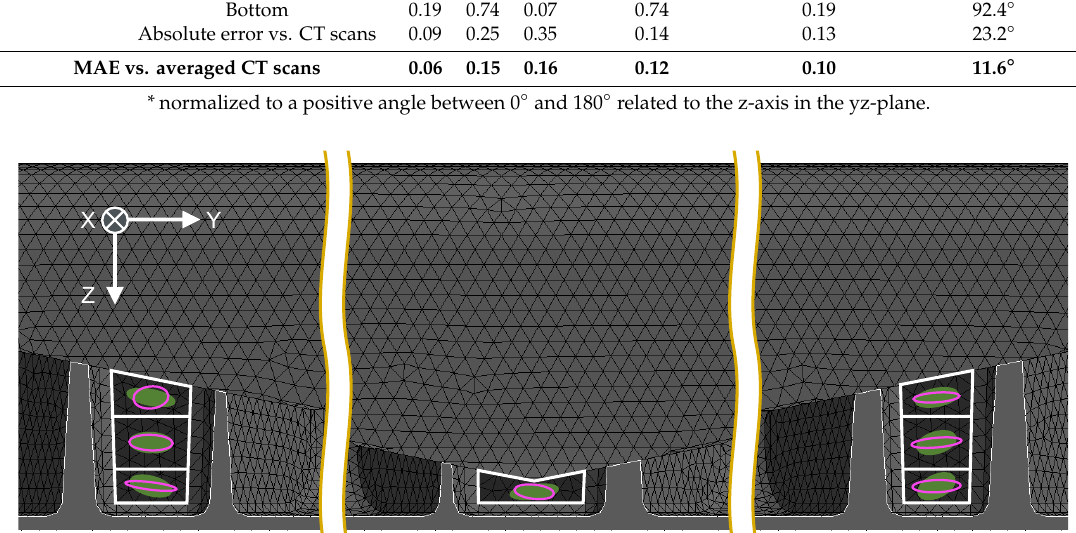
Figure 26. CAD image of the ribbed structure’s middle section (front view) with the rib analysis areas (white boxes) showing the determined averaged fiber orientations of all three CT scans in green superimposed with the fiber orientations predicted with 3D TIMON CompositePRESS in pink (both displayed as 2D ellipses on the used tetra mesh).